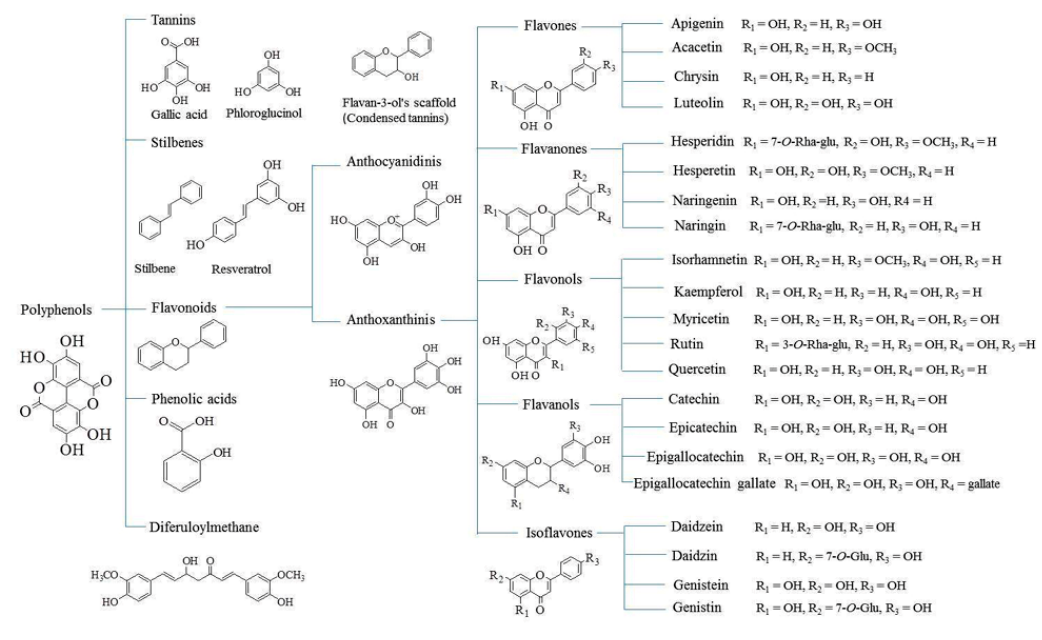
Figure 7. Classification of citrus polyphenols [11] .